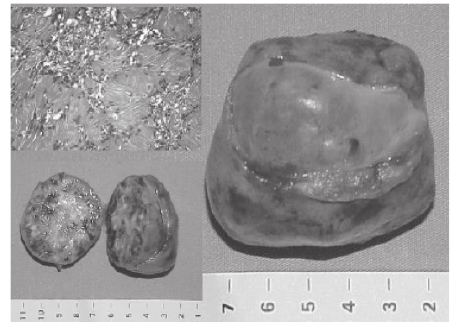
Figure 2 - Macro and microscopic view of the schwannoma. (50x -